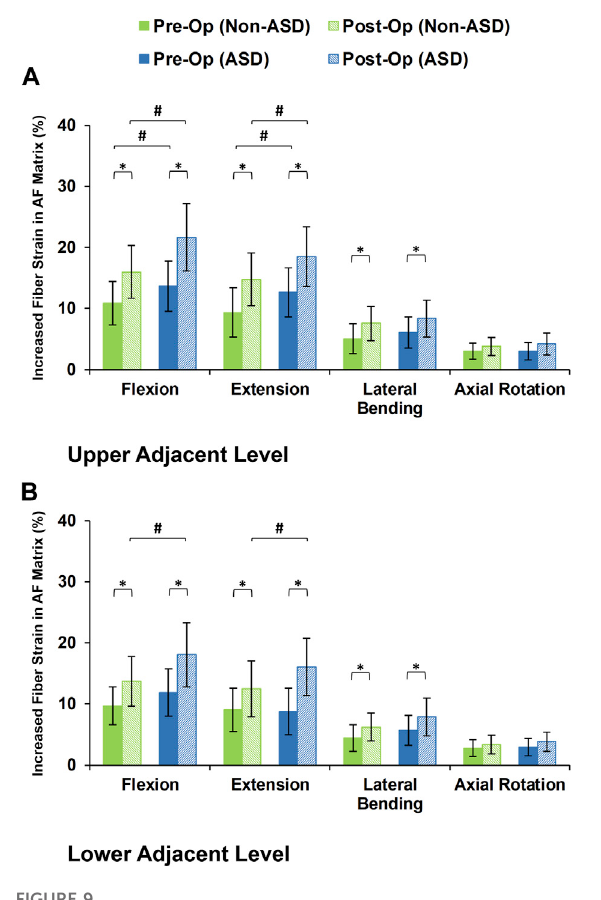
FIGURE 9 Increased collagen fi ber strain in AF matrix for post-operative non- ASD and ASD group FE models for the (A) upper and (B) lower adjacent